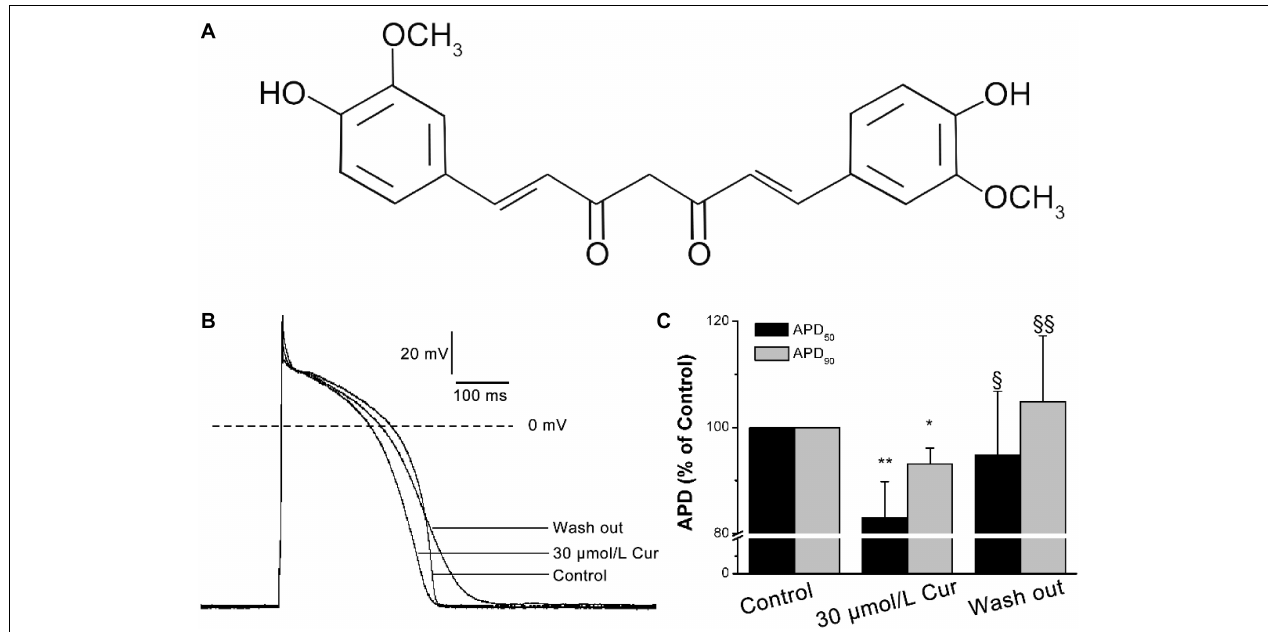
FIGURE 1 | Effects of Curcumin (Cur) on action potentials (APs) in ventricular myocytes. (A) Structural formula of Cur. (B) Example records of APs from the control group, Cur group, and wash out group in the same ventricular myocyte. (C) The comparisons of the average APD 50 and APD 90 percentage values of the control group, Cur group, and wash out group ( n = 12, * P < 0.05, ** P < 0.01 vs. control; § P < 0.05, §§ P < 0.01 vs. 30 µ mol/L Cur).